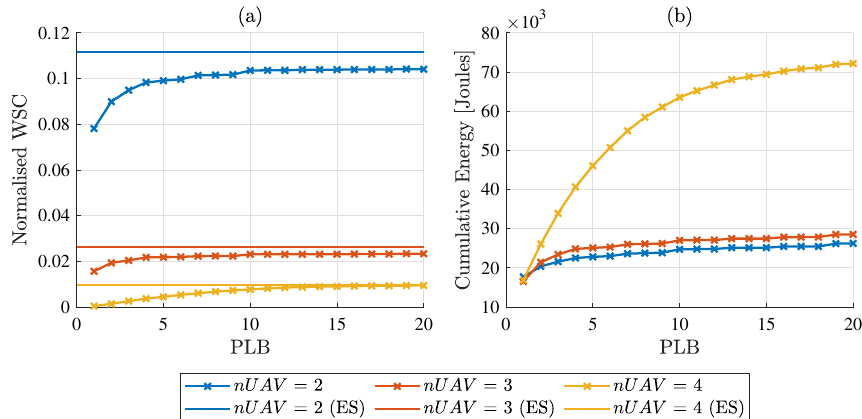
Fig. 8 a Normalised WSC mean values obtained over time, and b cumulative energy consumed in kilo‑Joules by all the UAVs over time. Both measured over PLBs with varying number of UAVs maintaining the total jamming power constant and compared to the exhaustive search (ES) results